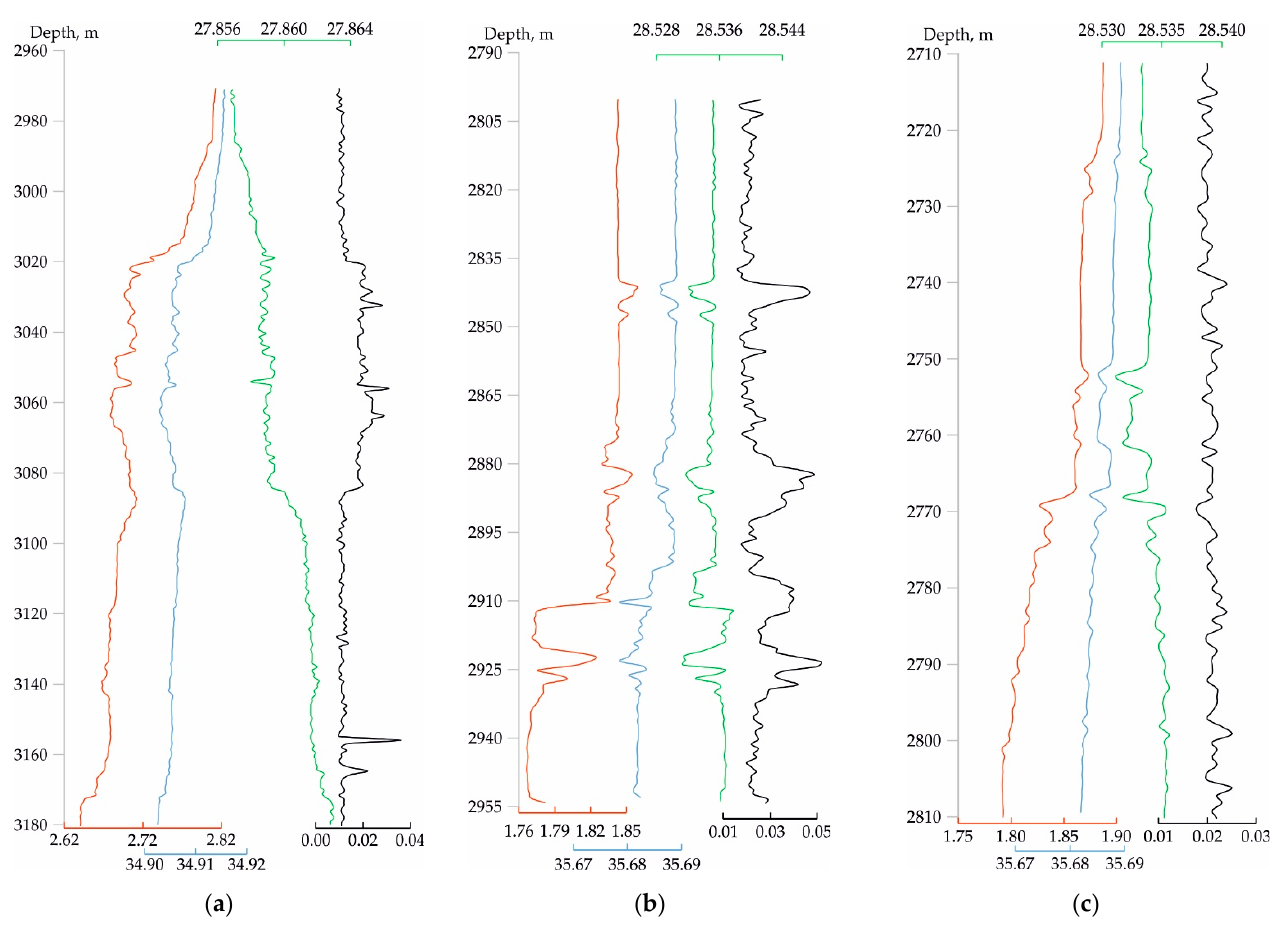
Figure 11. Changes in geophysical parameters near the Logachev ( a ), Ashadze-2 ( b ) and Koralovoye ( c ) HF’s: temperature (red, °C), salinity (blue, ‰ ), density (green, kg/m 3 ), turbidity (black, FTU).